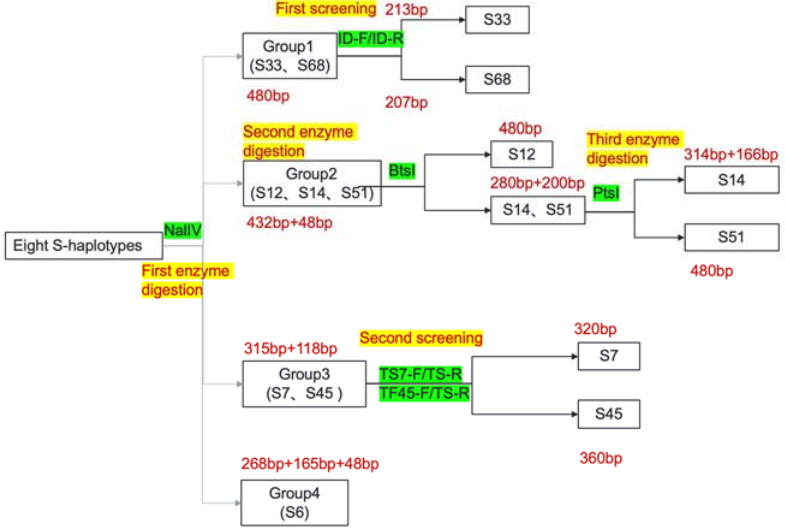
Figure 11. Identification flow chart of 8 S ‐ haplotypes in cabbages.